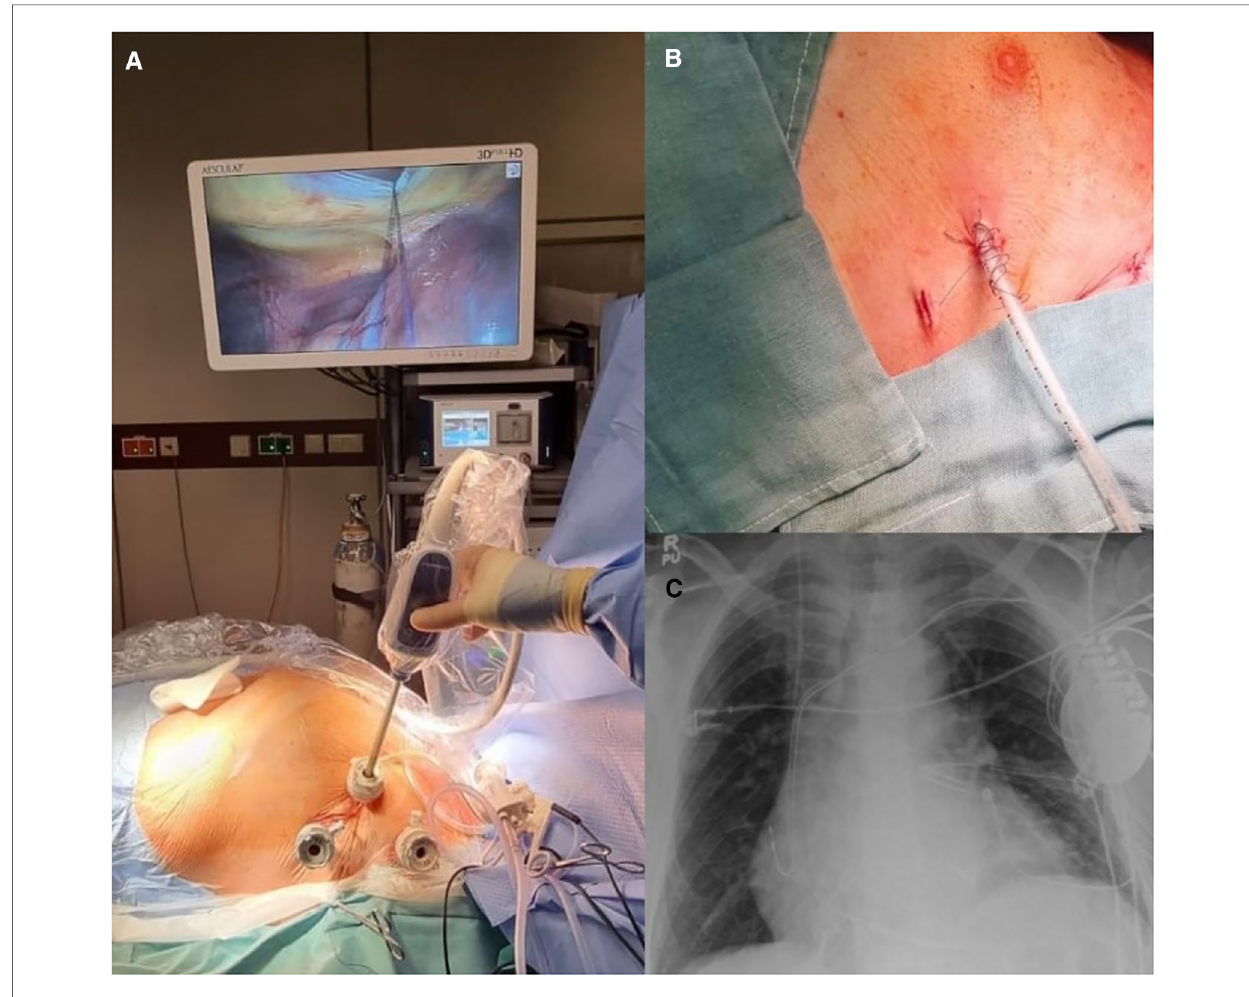
FIGURE 1 ( A ) Intraoperative picture showing the three-port access and the 3D videoscopic guidance. ( B ) Postoperative state after wound closure. ( C ) Postoperative chest x-ray showing the CRT-D device with the epicardial LV lead and the AtriClip PRO2 ®